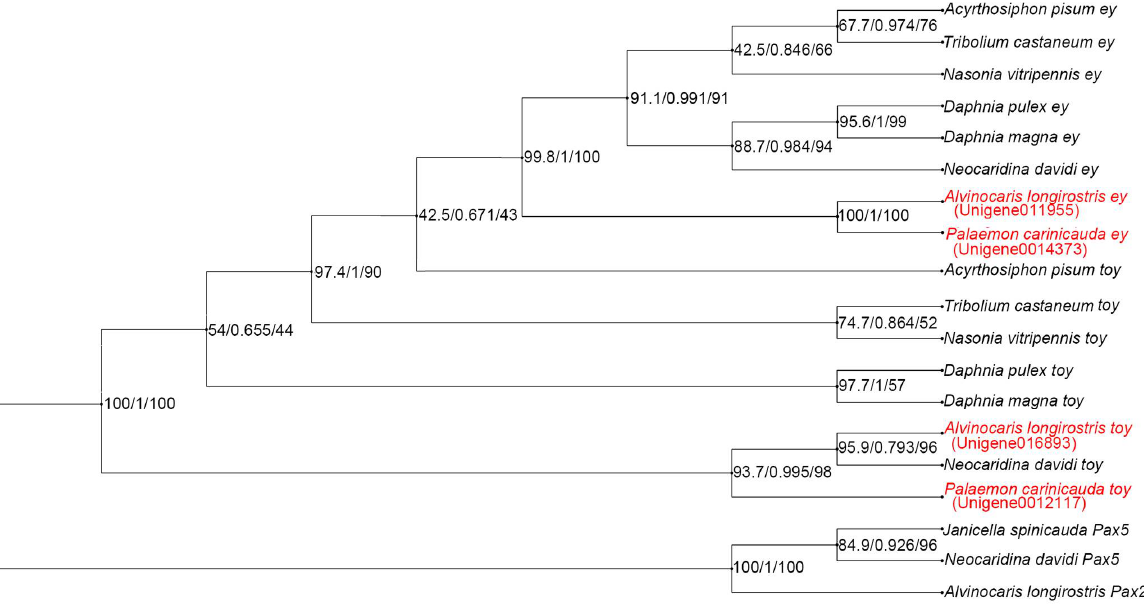
Figure 3. Phylogenetic tree of Pax homologs. Numbers above branches represent branch support values of SH-aLRT support (%)/aBayes support/ultrafast bootstrap support (%).